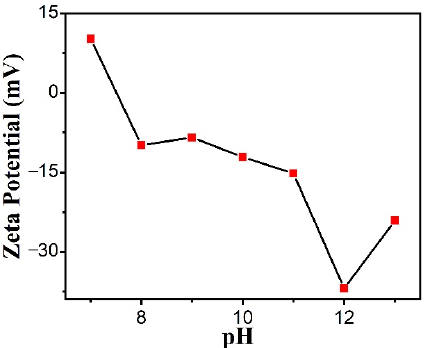
Figure 4. Zeta potential of CuO nanosheet with different values of pH.